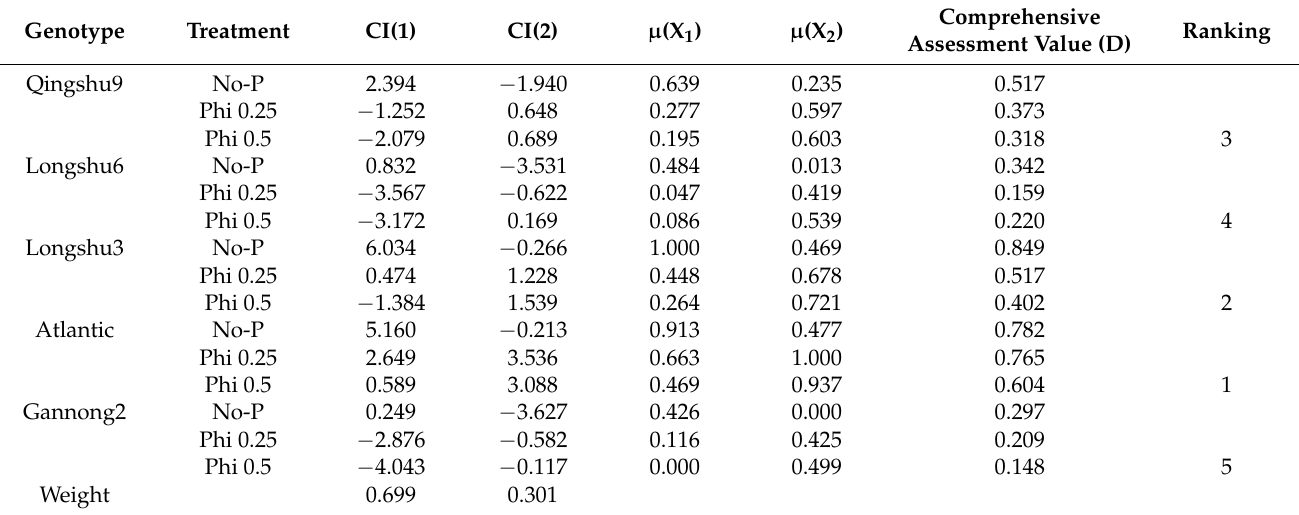
Figure 6. Scatter diagrams of arranged first two main components; PC1/PC2. Table 4. Comprehensive index (C1), index weight µ (X), and comprehensive evaluation (D) of five potato genotypes under Phi and No-P